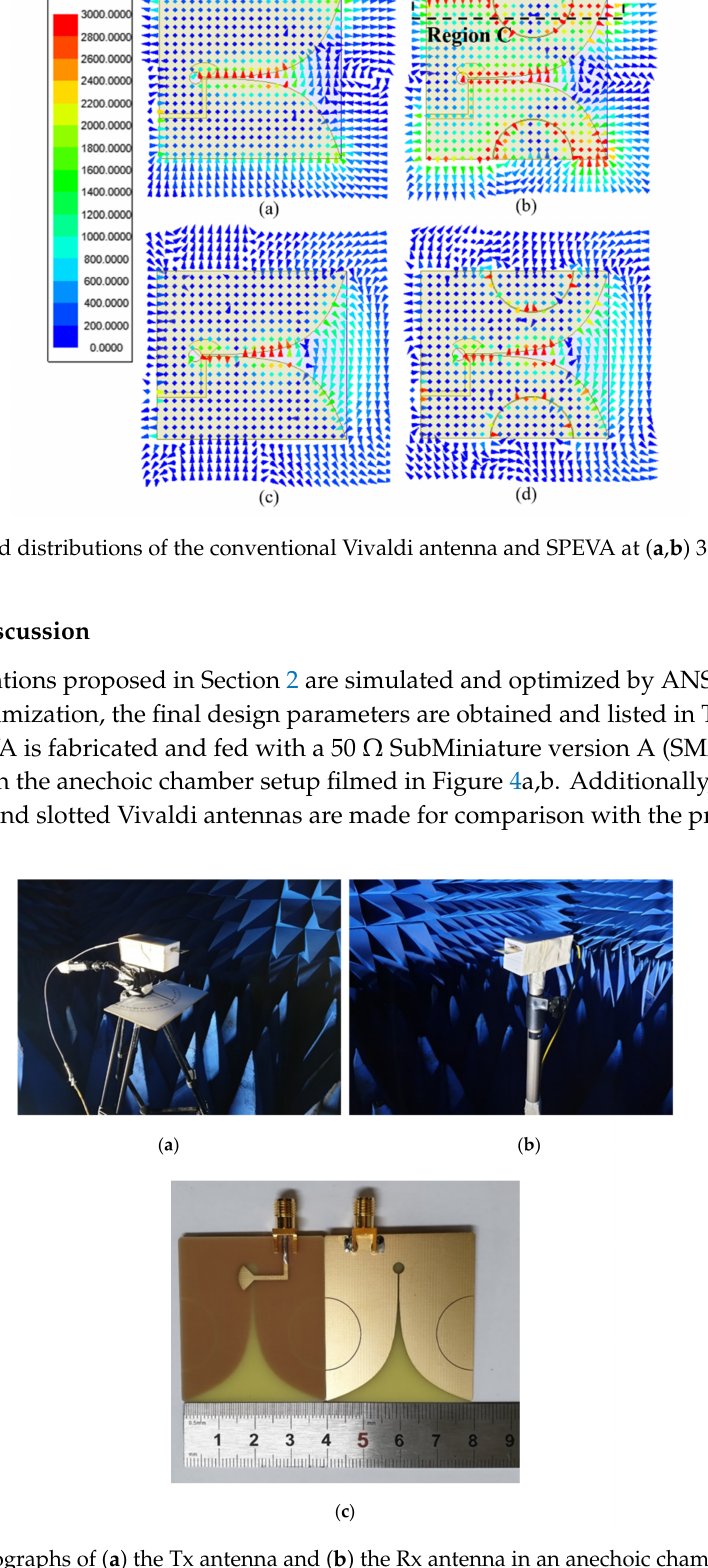
Figure 4. Photographs of ( a ) the Tx antenna and ( b ) the Rx antenna in an anechoic chamber and ( c ) the fabricated